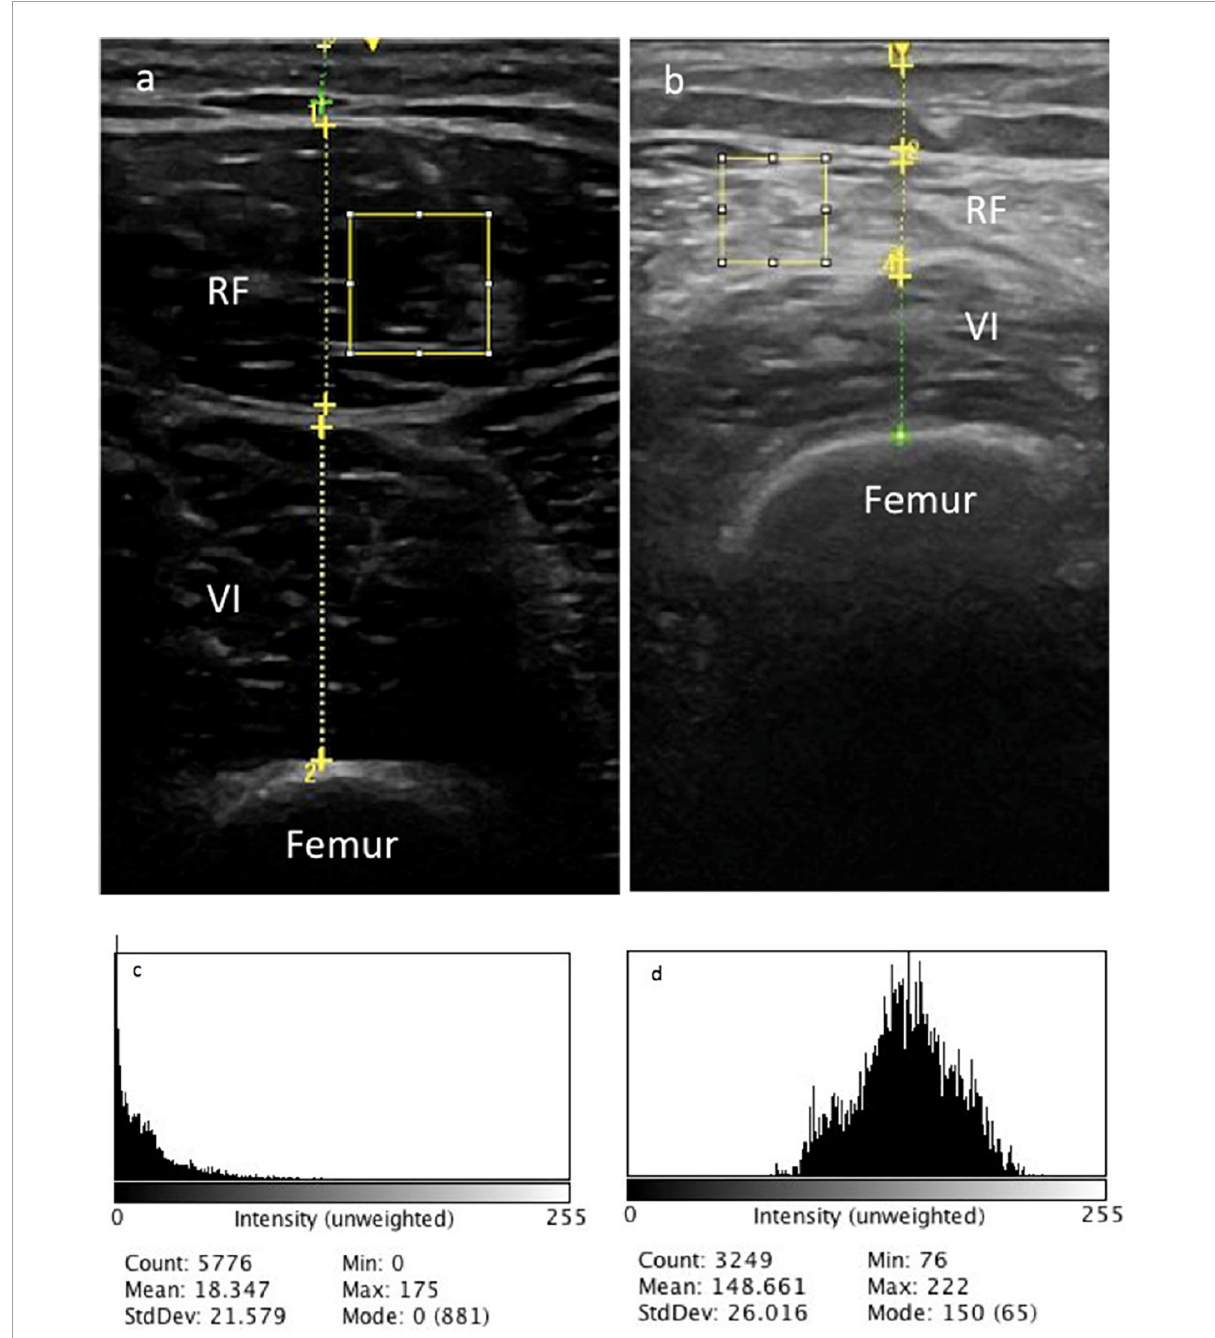
FIGURE1 Muscle thickness of right rectus femoris (RF) and vastus intermedius (VI) muscles ultrasonography of two different long COVID patients (a,b) . The selected area represents the region of interest (ROI). Histogram of RF echo intensity of patient a (c) and patient b (d) .